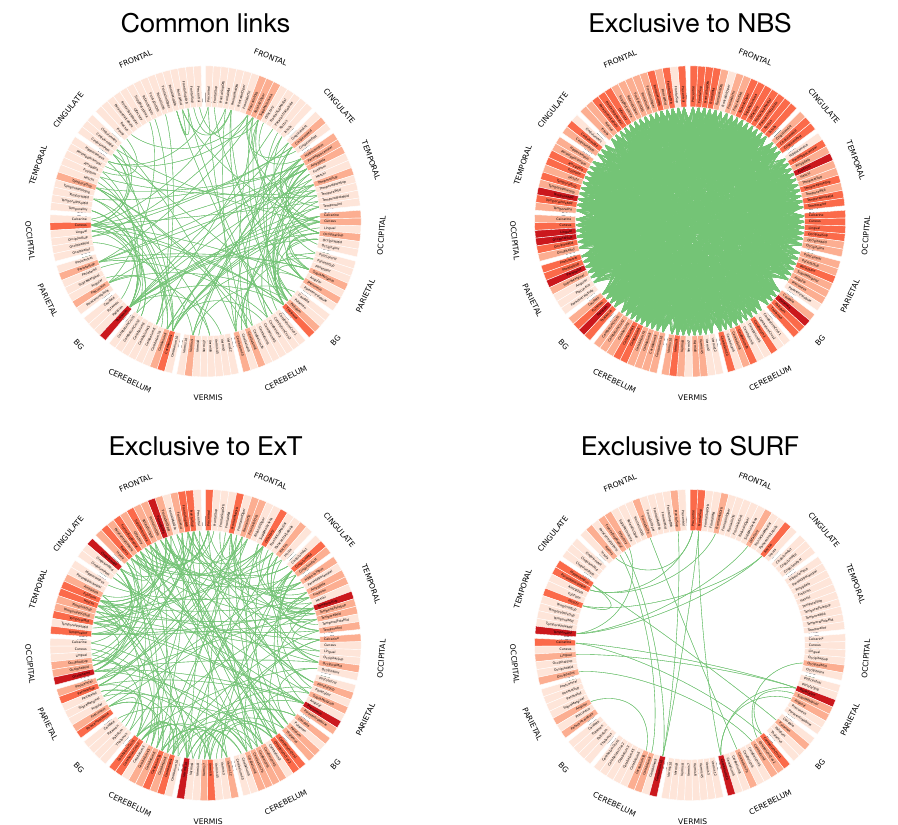
Figure 7. Graphical representation of the links common and exclusive to the three best performing methods, in terms of AUC. Specifically, the top left panel reports the circular representation of the links common to NBS, ExT and SURF; while the other three, the set of links that have exclusively been selected by respectively NBS, ExT and SURF. Nodes (i.e., of Regions of Interest, see Section 3.1) are labelled according to the corresponding name in the AAL parcellation; colors indicate their degree, from light (no or few connections) to dark shades (maximum degree). The four panels have been prepared using the Circos software [91].